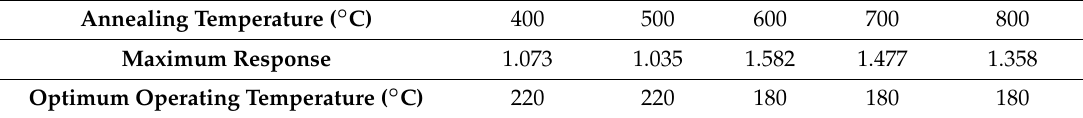
Table 1. Maximum acetone sensing response and optimum operating temperature of SnO 2 sensors.